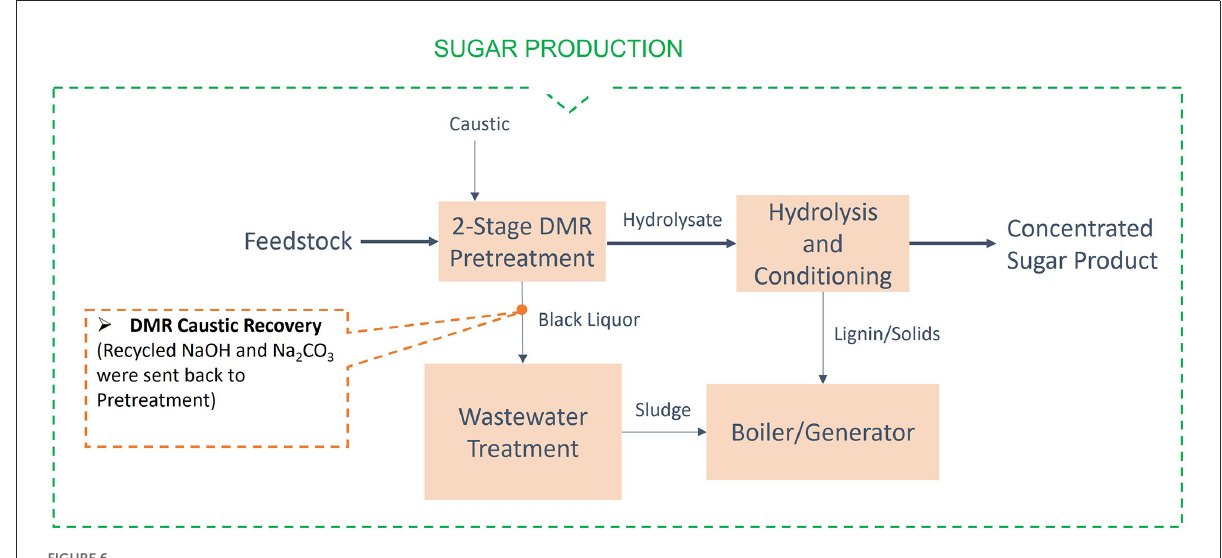
FIGURE6 Process diagram for the sugar production with the locations of the separation challenge